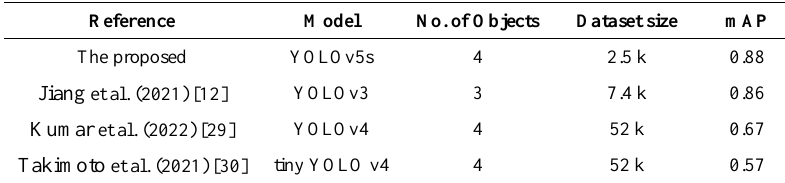
Table 2. Comparison between the proposed model with other